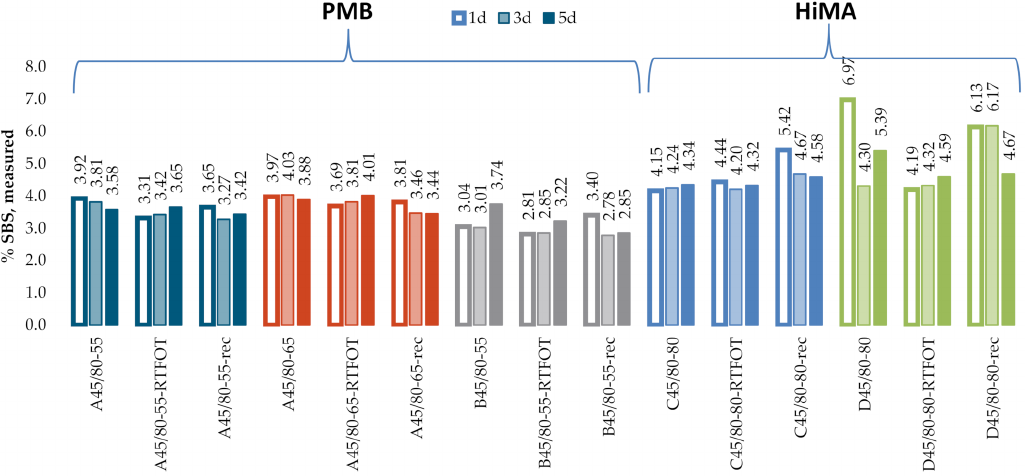
Figure 14. SBS contents measured on industrial